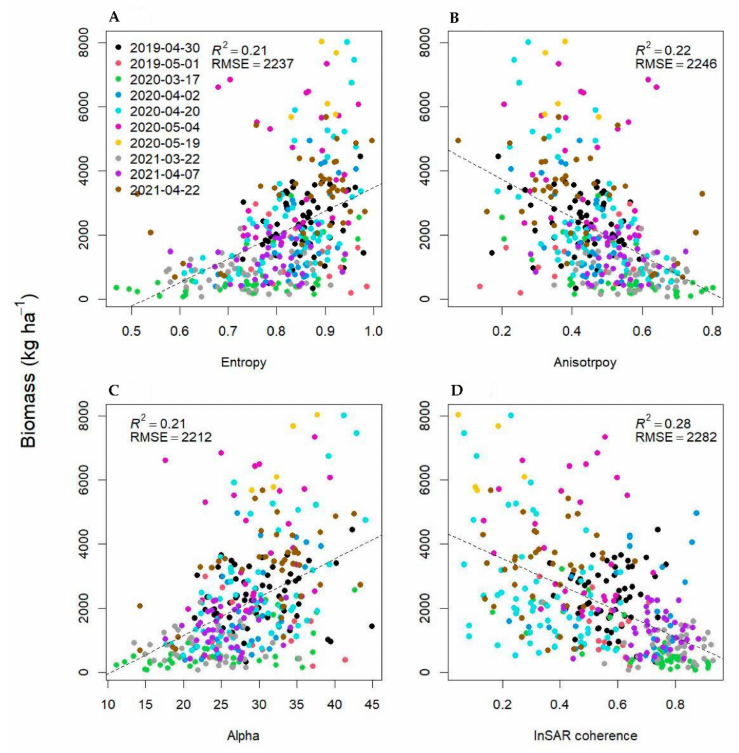
Figure A4. Biomass as a function of synthetic aperture radar polarimetric decompositions (alpha angle—( A ); anisotropy—( B ); entropy—( C )) and interferometric (InSAR) coherence ( D